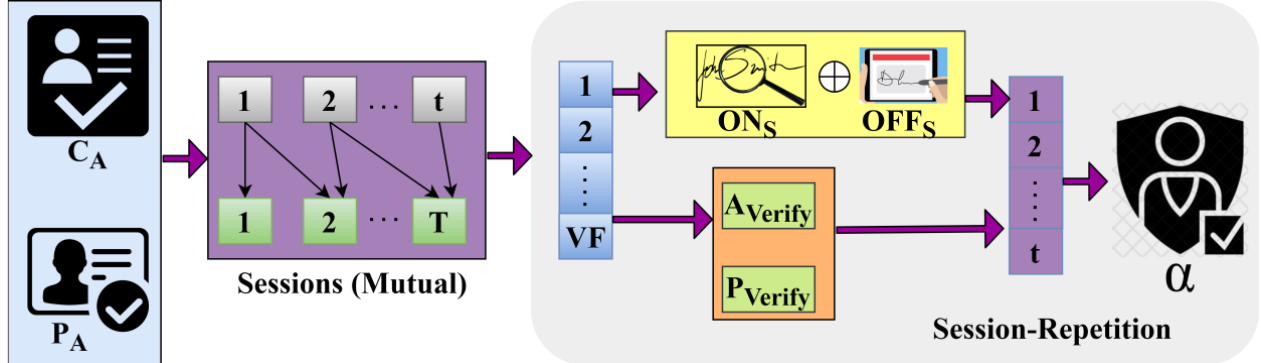
Figure 4. Information verification process.